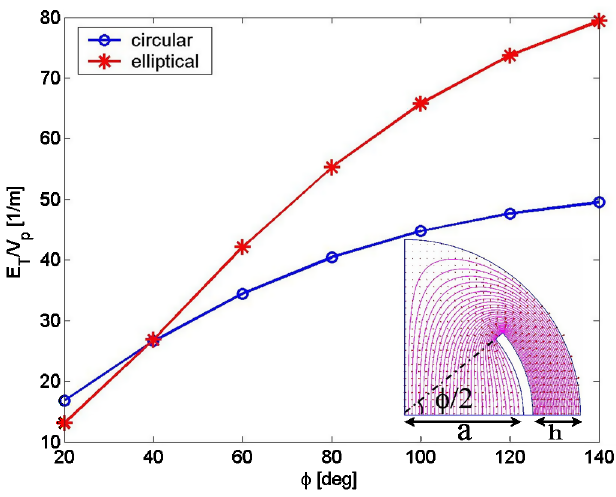
FIG. 3. Total equivalent deflecting field E voltage per strip) at the center of the structure as a function of the coverage angle (cid:3) (stripline half-aperture a ¼ 25 mm ).